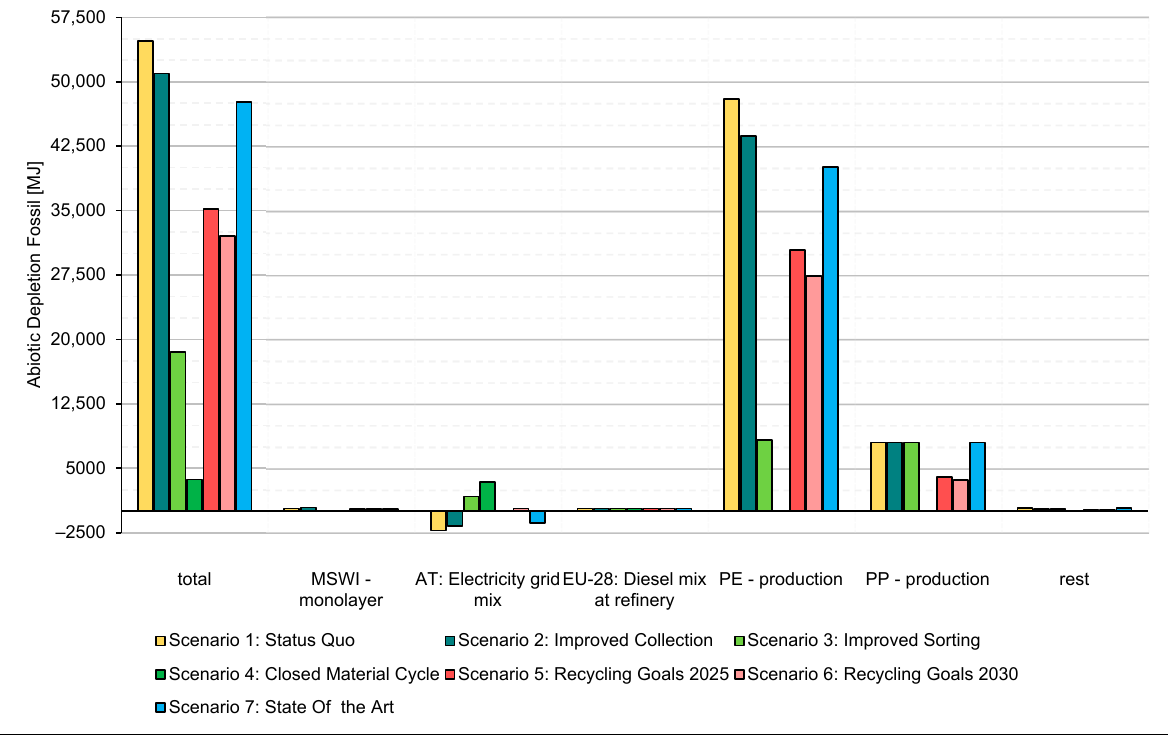
Figure 14. ADPF of the individual processes over the product lifecycle.